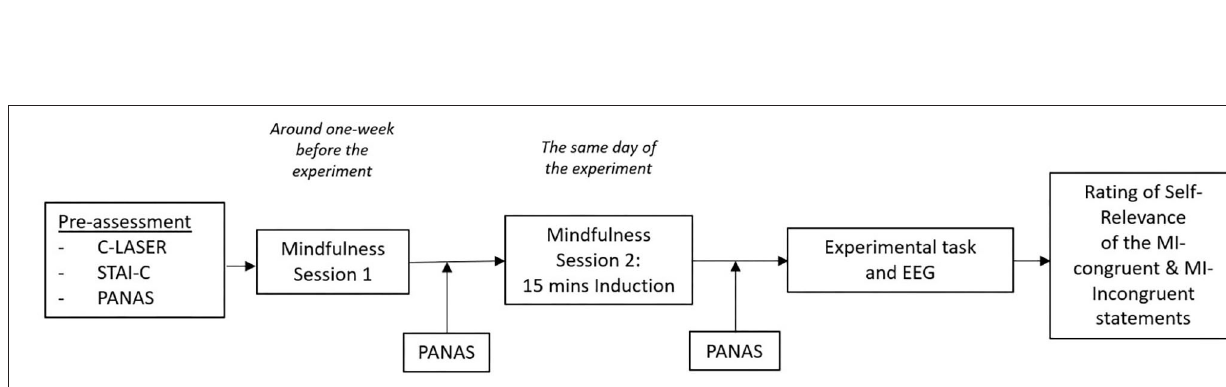
FIGURE 2 | The flow of the